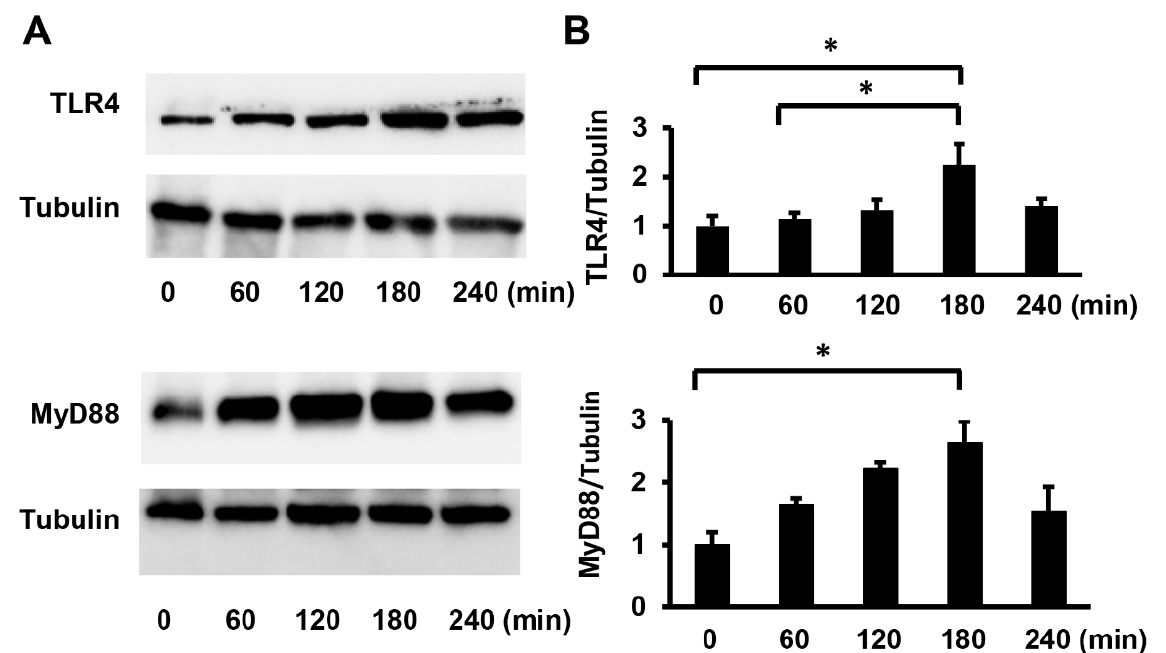
Figure 2. Pg -LPS increases TLR4/MyD88 expression in HASMCs. ( A ) The expression of TLR4 and MyD88 in HASMCs after Pg -LPS treatment. HASMCs were treated with Pg -LPS (100 ng/mL), and the TLR4 and MyD88 protein levels were determined by Western blot analysis. Representative blots are shown. ( B ) Quantitative analysis of TLR4 and MyD88 protein levels. Protein levels were quan- tified using Image J. n = 5 in each group. * p < 0.05. Data are presented as mean ± SE.